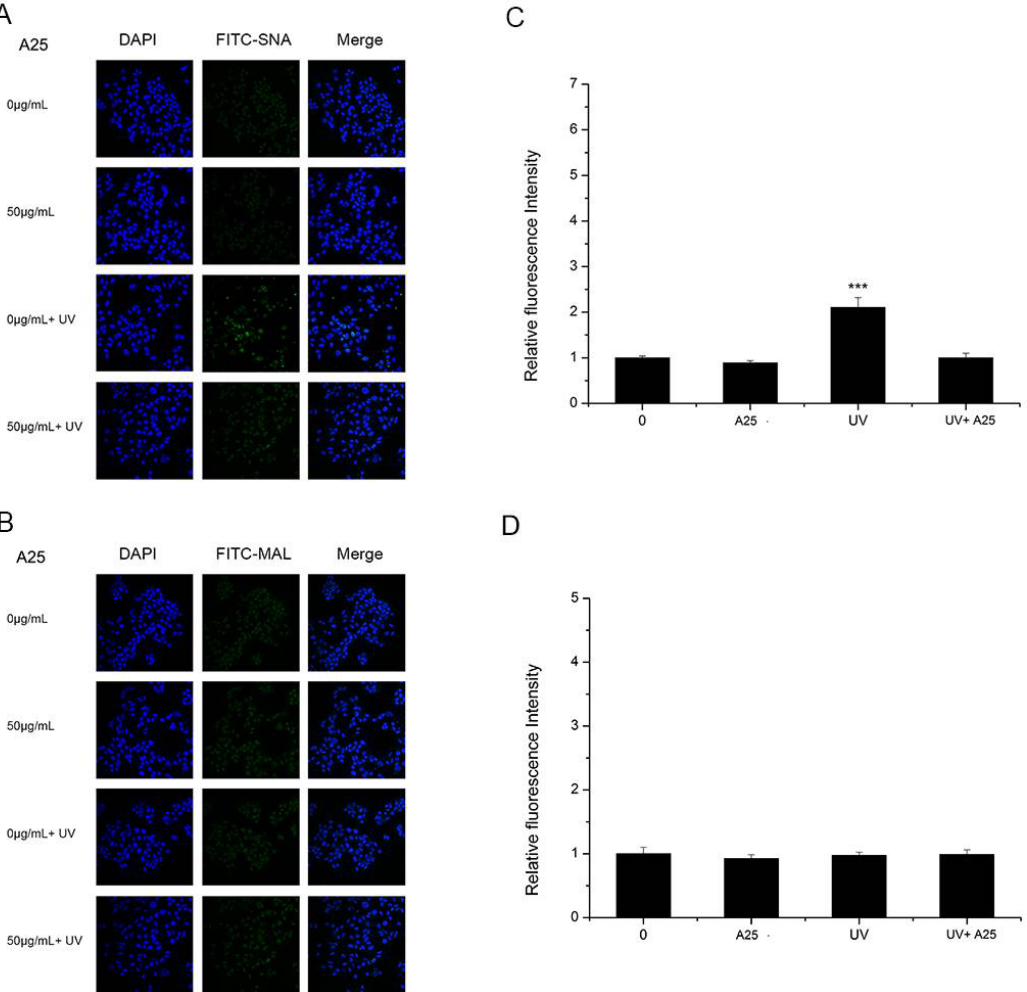
Figure 4. HaCaT cells were treated with 50 μg/mL nano-TiO 2 A25, UV or the combination of nano-TiO 2 A25 and UV. Staining was performed with FITC-labeled ( A ) SNA for α-2,6 sialic acid residues (green), ( B ) MAL for α-2,3 sialic acid residues (green), and DAPI for nuclei (blue). The bar graphs show the fluorescent intensity analysis for ( C ) A and ( D ) B (*** p < 0.001, error bars are standard error of the mean).